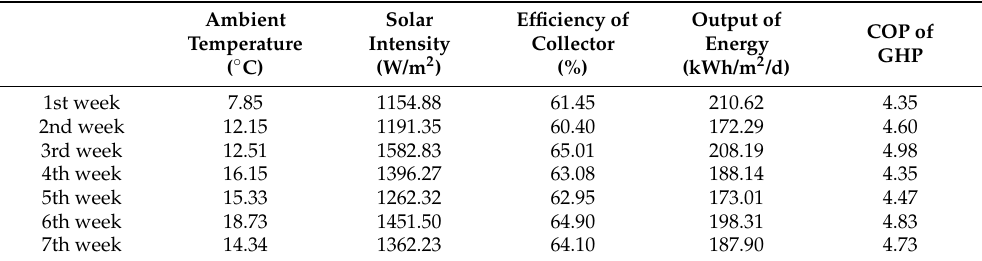
Table 5. Coefficient of performance (COP) of the GHP system and calculated collector’s efficiency and energy output of evacuated tube collectors of the solar system.